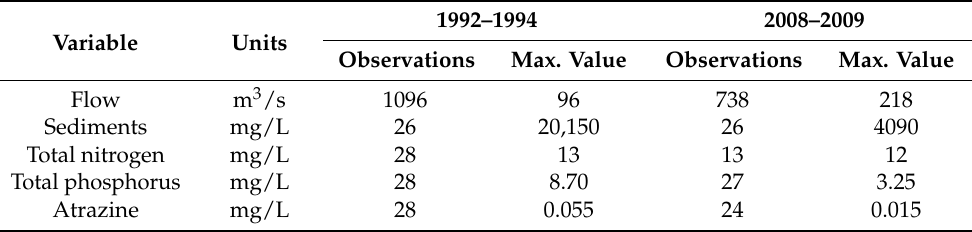
Table 1. Shell Creek water quantity and quality data synthesis for two periods between 1992–2009. Variable